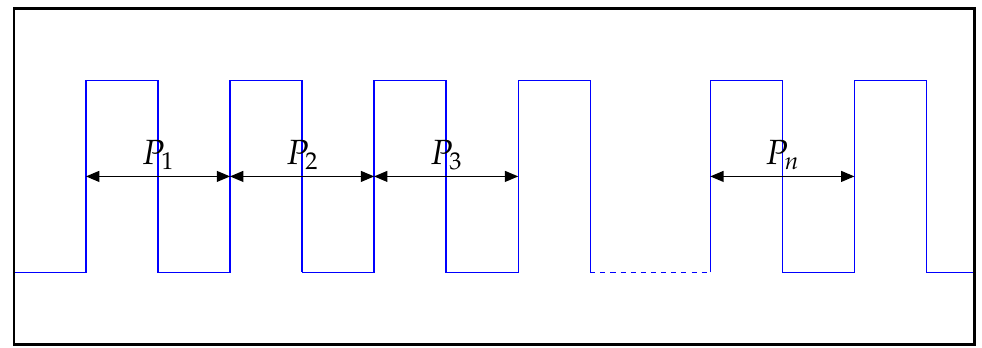
Figure 10. Cycle-to-Cycle-Jitter Using Equation (5), the Cycle-to-Cycle-Jitter can be calculated for the measured signal. Jcc is a list of values which contains the separate Jcc values for each period of the signal. The symbols P 1 to P n represent the individual periods of the considered